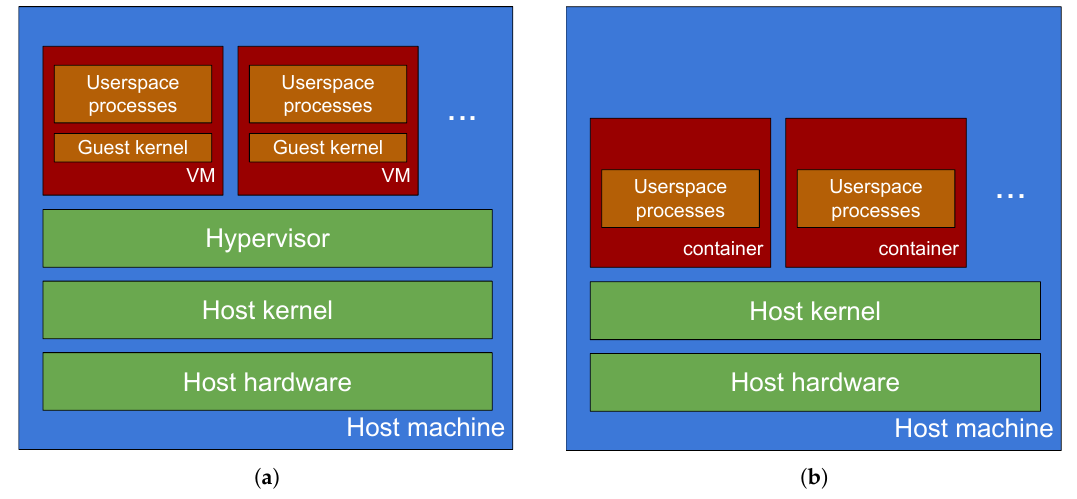
Figure 2. Hardware virtualisation ( a ) vs. containerisation ( b